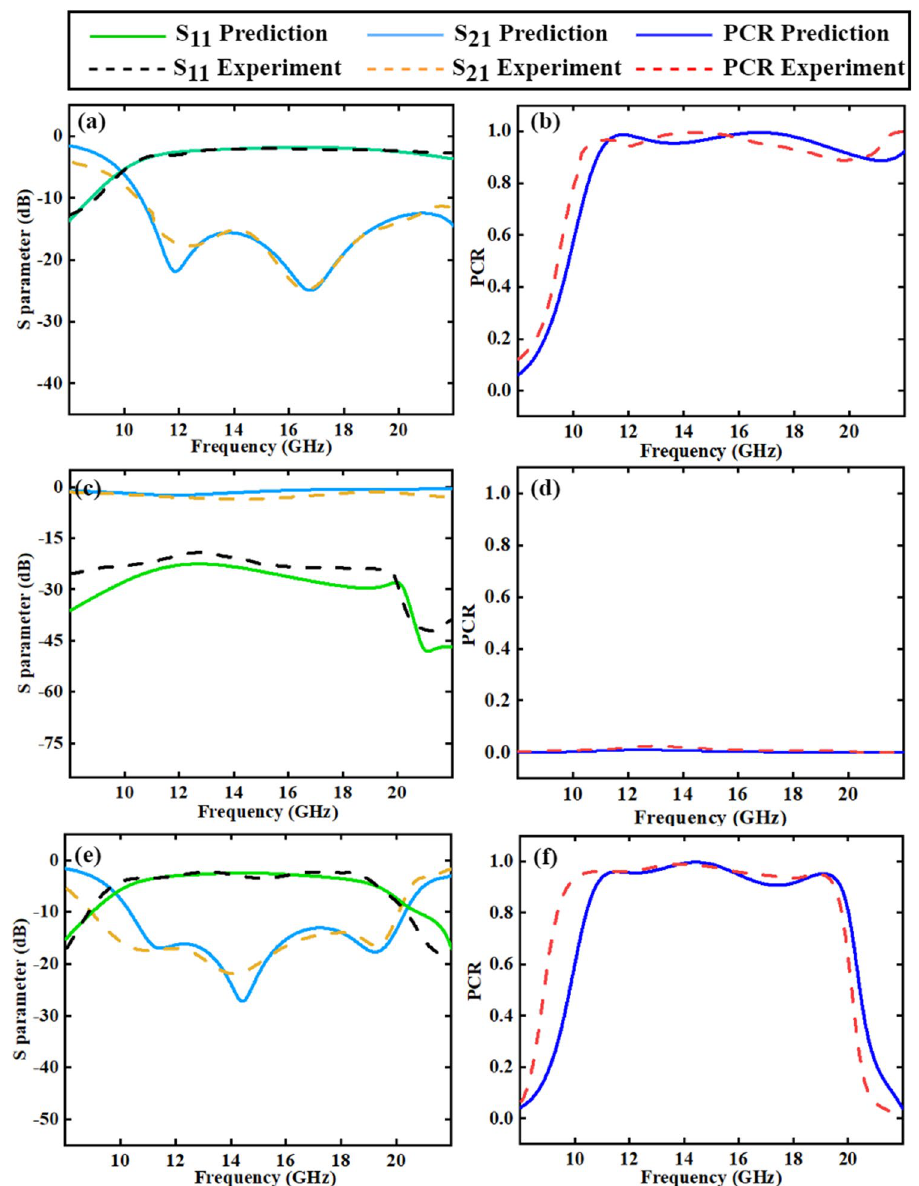
Figure 9. Comparison between the simulation results of the design target and experiment data, including S11, S21, and PCR spectrum which are represented by dotted Lines and lines. ( a ) ( c ) ( e ) are the S-parameter spectra of samples 1, 2, and 3, ( b ) ( d ) ( f ) are the PCR spectra of samples 1, 2, and 3, respectively. (Plotted in OriginPro